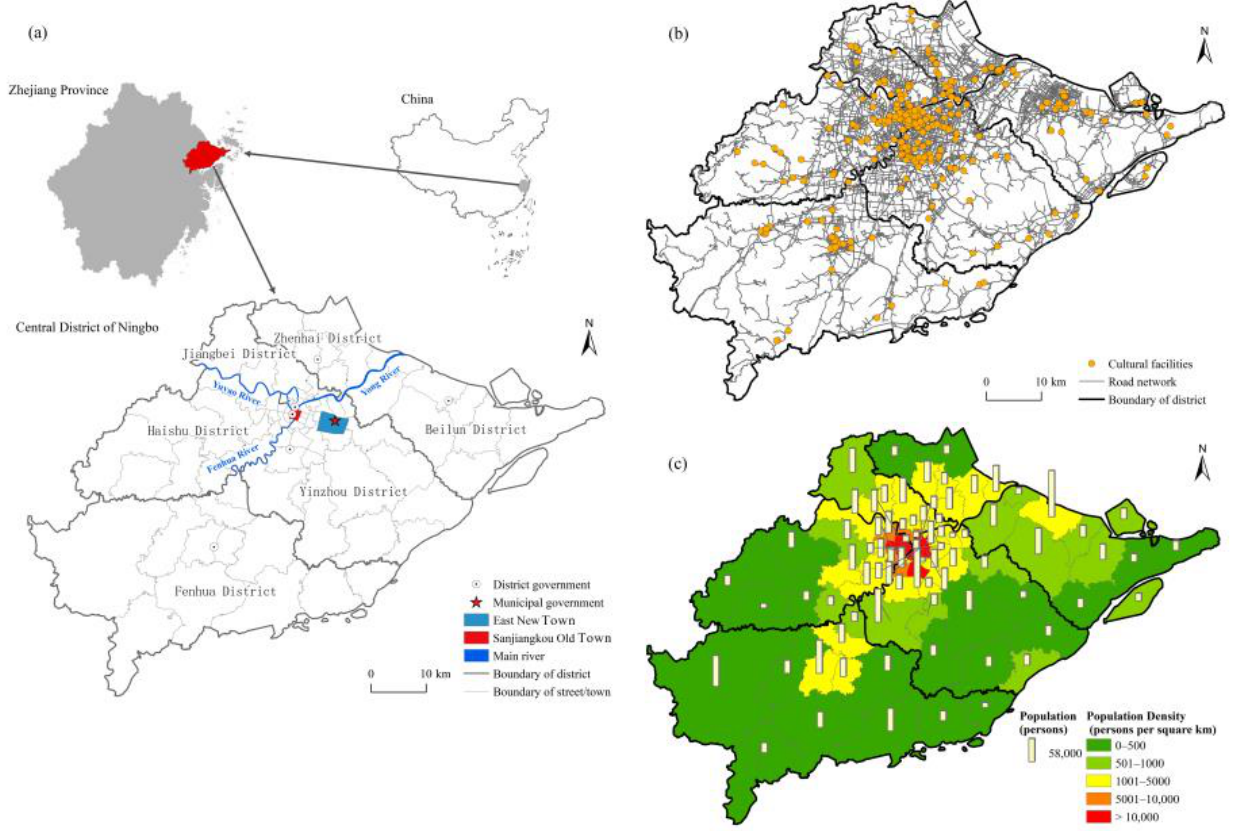
Figure 2. The location ( a ), cultural facilities ( b ), and population ( c ) of the study area. Note: This map is based on the standard map of the Map Technical Review Centre of the Ministry of Natural Resources of China (Number: Zhejiang S (2022)34), with no modifications to the base map. Map-making by the author.